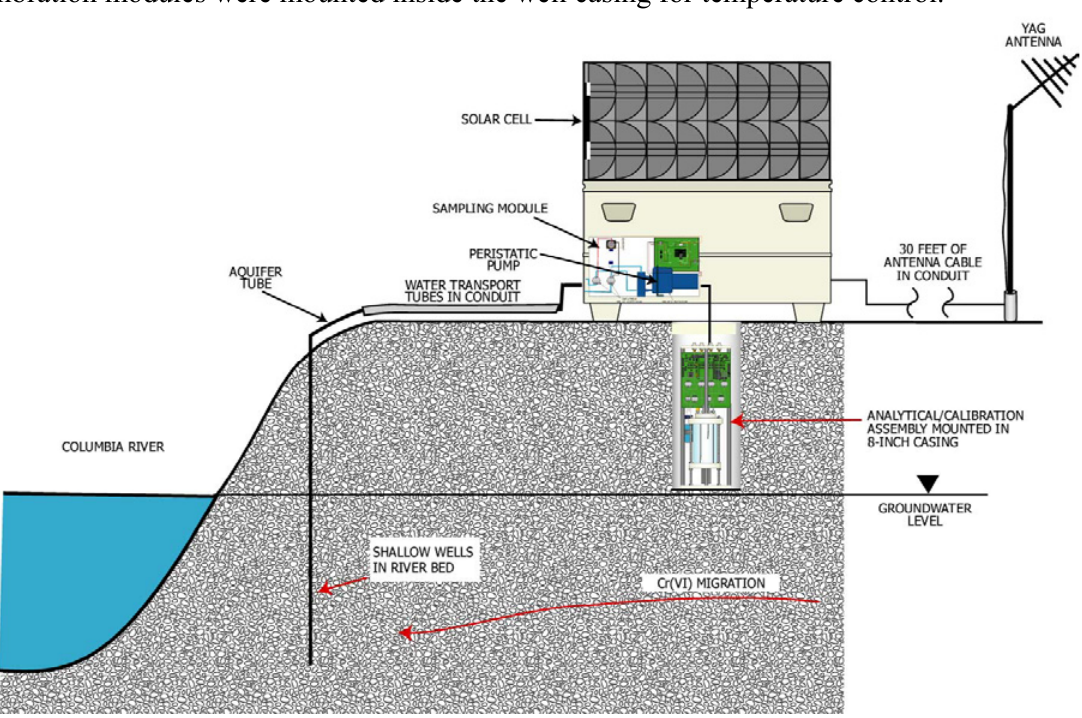
Figure 2. Field implementation